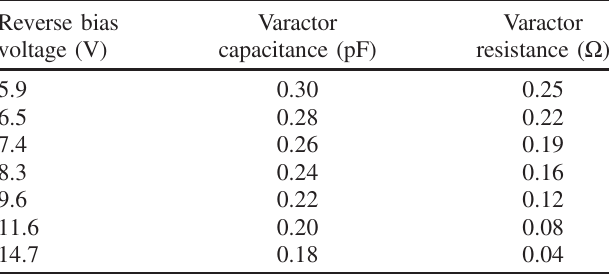
TABLE I. Varactor (MAVR-000120-1411) capacitance and resistance verses reverse bias voltage, extracted from the SPICE